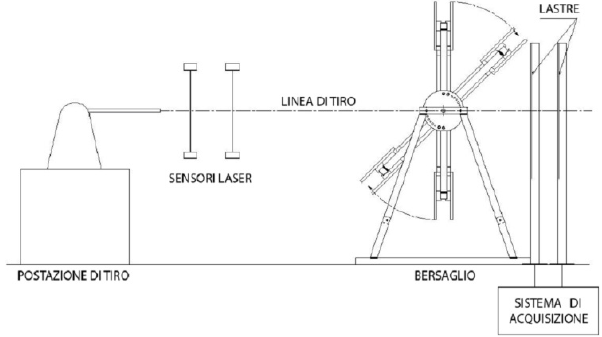
Figura 3: Set-up